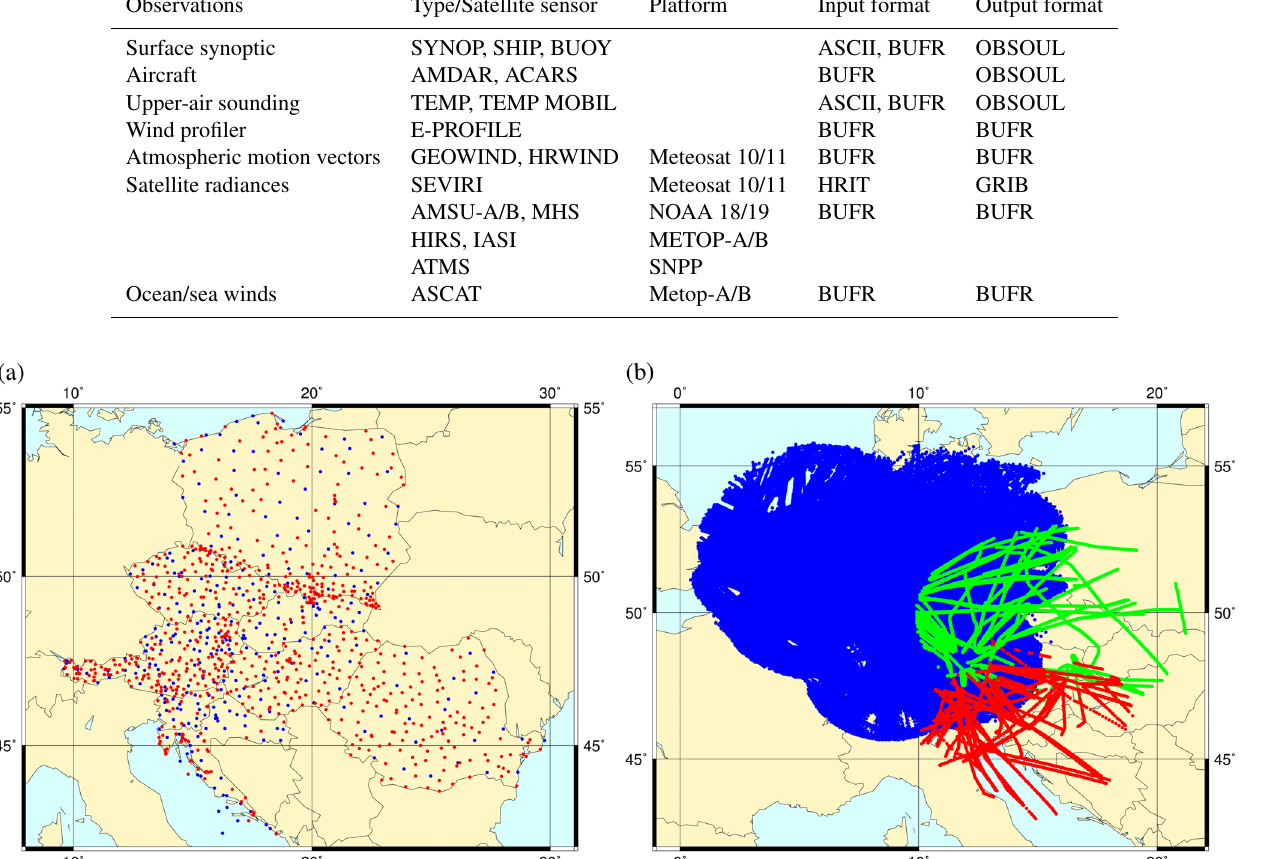
eventually perform format conversions and the splitting into hourly